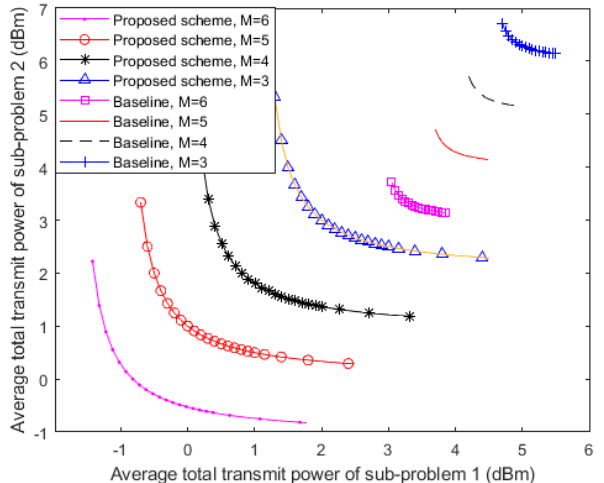
Figure 4. Average transmit power trade-off region between the two sub-problems of each device achieved by the proposed power minimization resource allocation policy. The baseline is simulated under the parameters of the FD BS antenna numbers with M = 6, M = 5, M = 4 and M = 3.